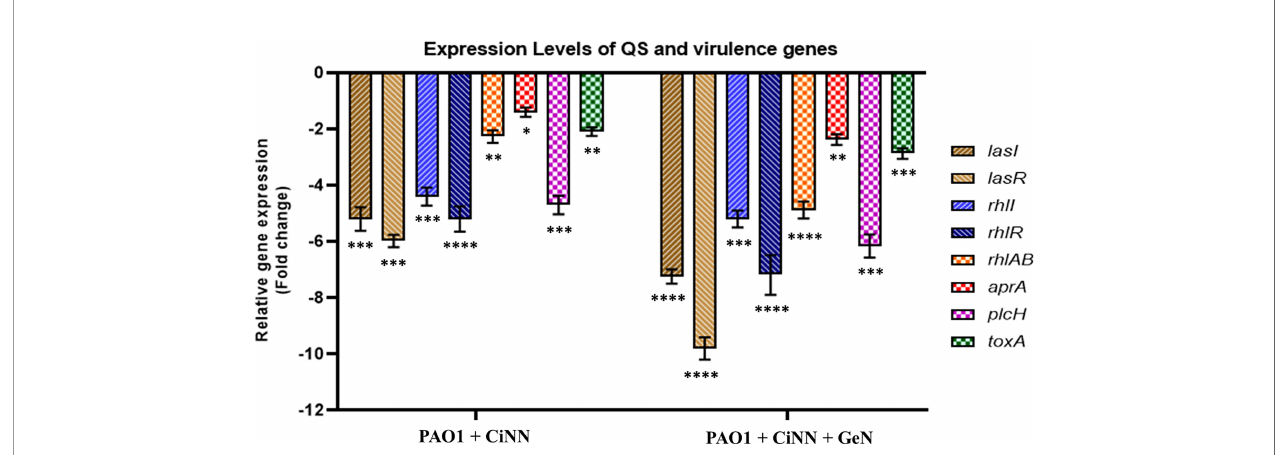
FIGURE 4 | Relative expression of key QS-related genes ( lasI , lasR , rhlI , and rhlR ) and virulence genes ( rhlAB , aprA , lasB , toxA, and plcH ) associated with the production of virulence factors in P. aeruginosa , in the presence of CiNN alone and CiNN-GeN combination. Gene expression has been normalized with GAPDH and depicted relative to the expression of genes in the untreated control. (*p ≤ 0.1, **p ≤ 0.01, ***p ≤ 0.001, ****p ≤